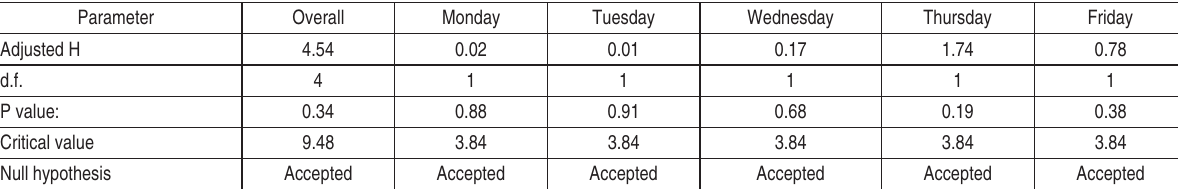
Table B9. Kruskal-Wallis test of the day-of-the-week effect for UX futures